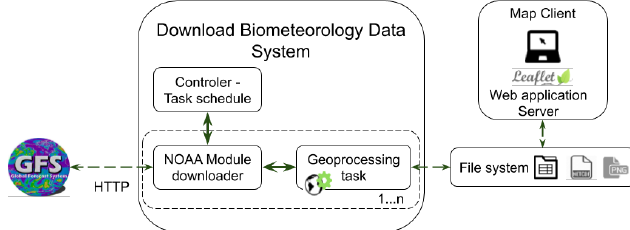
Figure 1. System designed to download and geoprocessing data for Biometeorological analysis. The controller component schedules and initiates all tasks coded in modules like NOAA module. The results are stored as files in different formats. Maps can be requested through web